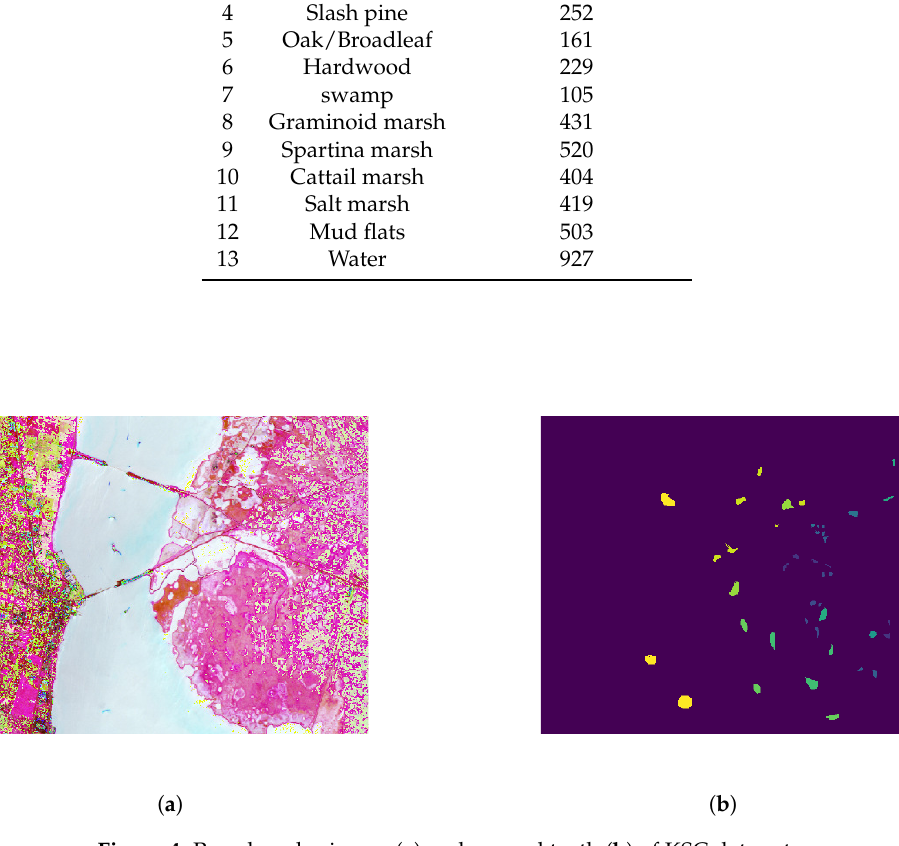
Figure 4. Pseudo-color image ( a ) and ground truth ( b ) of KSC data